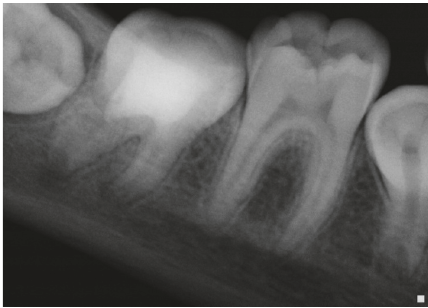
Figure 4: Radiograph after 3 months’ recall: reduction of the radio- lucent image at the distal root.